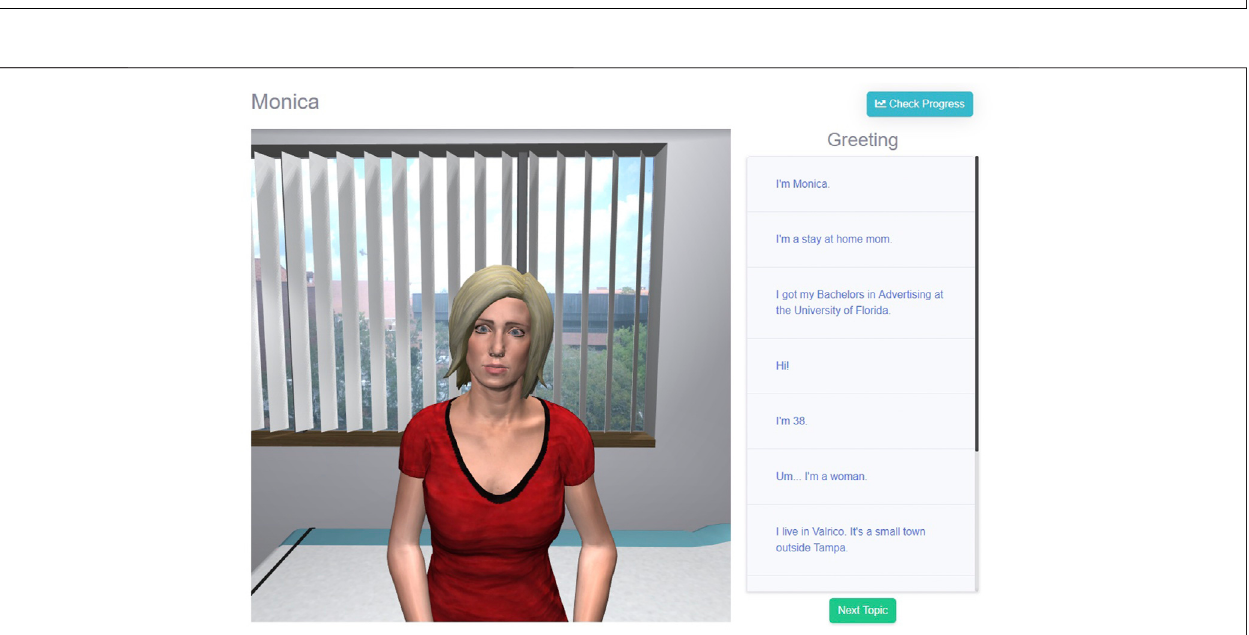
FIGURE 2 | The Selection interface featuring Monica Roberts.